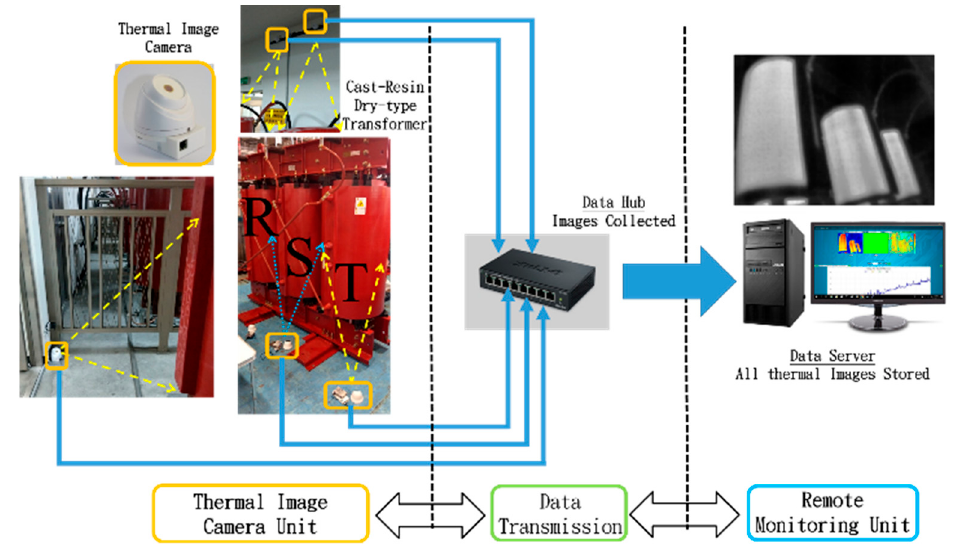
Figure 1. The experimental environment setting of cast-resin transformer.